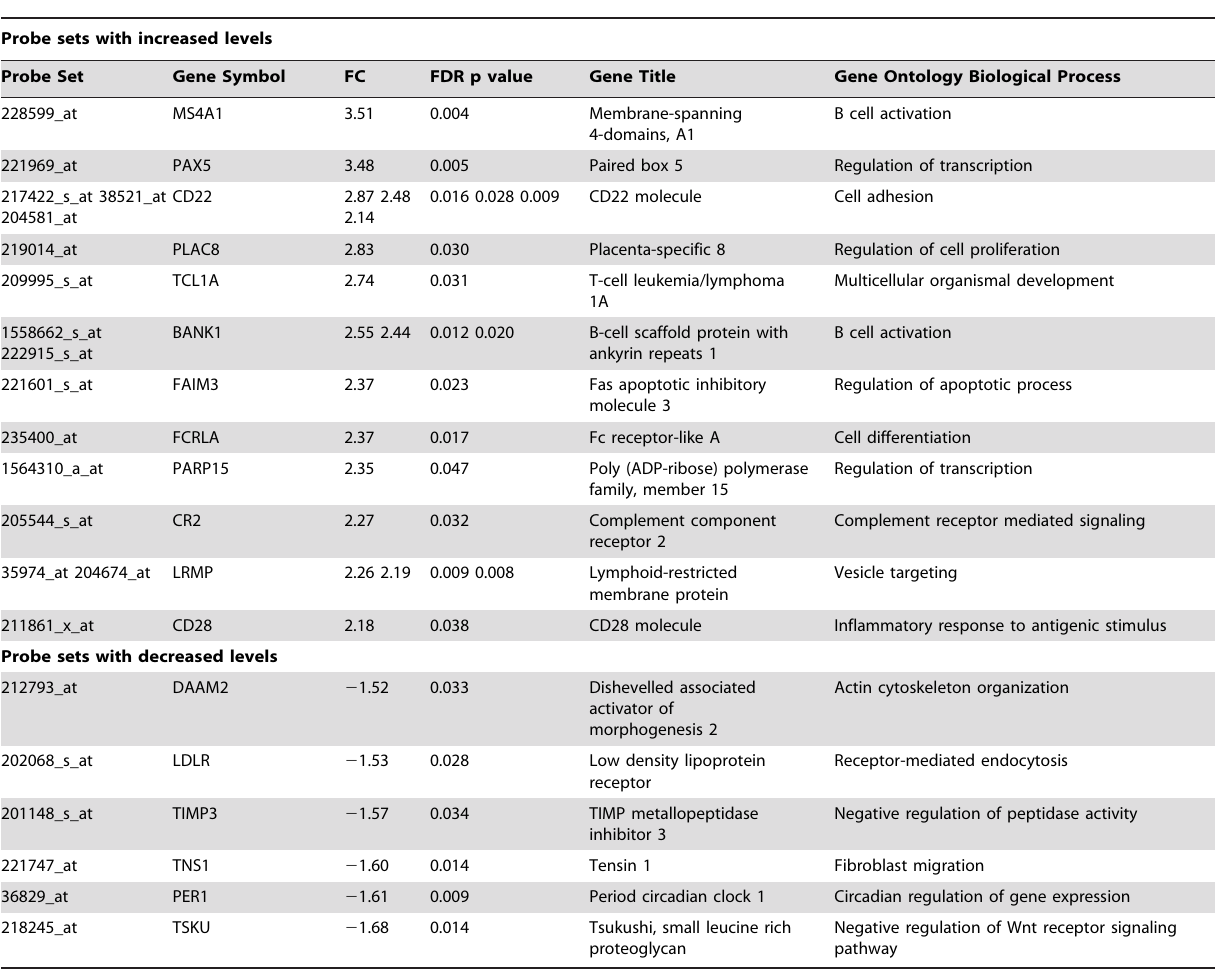
Table 5. Examples of gene expression differences comparing IgG4 + to IgG4- lacrimal gland tissue from subjects with NSOI, GPA, or